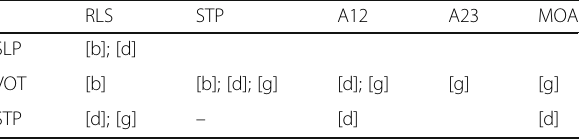
Table 10 Summary of results from the correlation analysis when different places of articulation were considered separately: identification of the place of articulation for which the correlation is significant at the .05 significance level, considering the Spearman rank-based correlation test